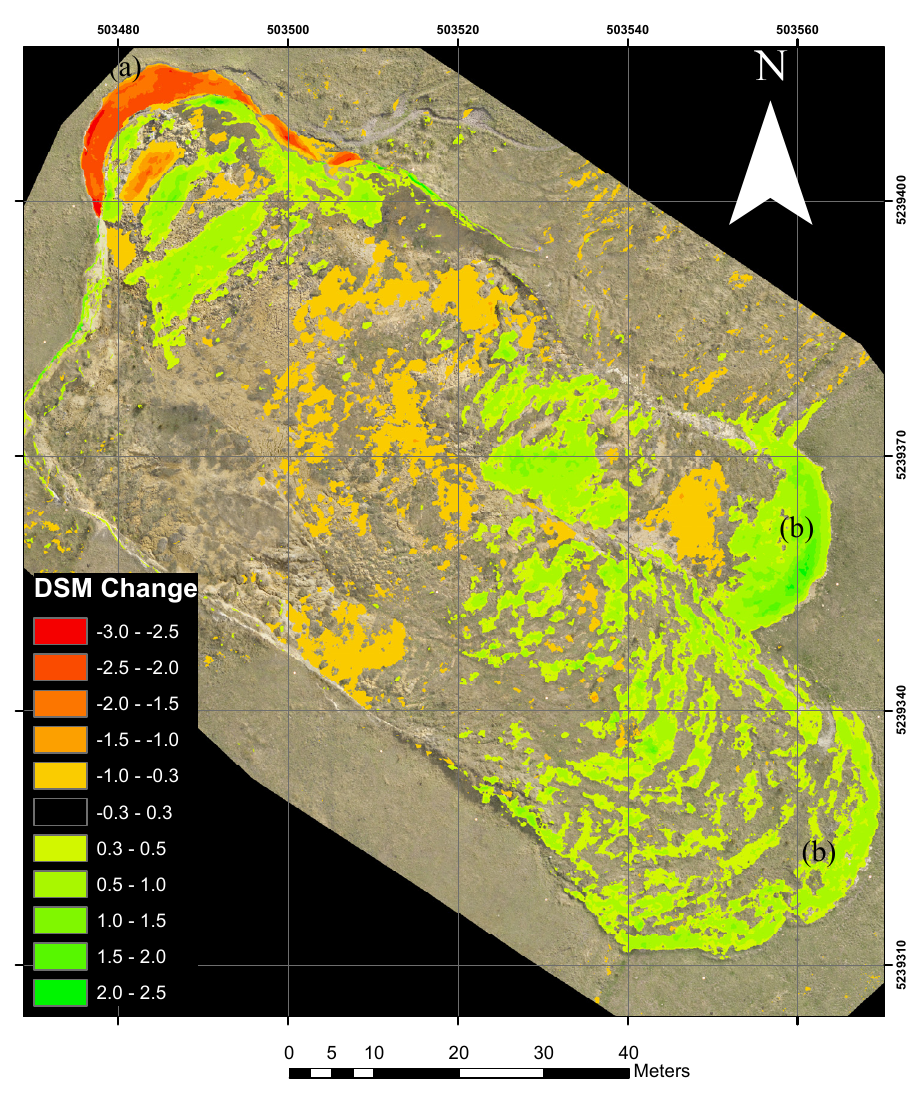
Figure 4. 2012A to 2013A DSM change: ( a ) area of scarp collapse; ( b ) areas of toe advance (coordinate system: GDA94